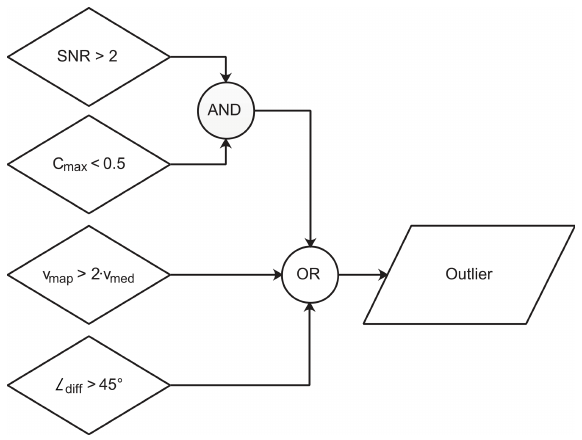
Figure 3. Two-step outlier detection approach, with C max being the maximum and C mean the absolute mean value for each correlation function. The signal-to-noise ratio (SNR) is calculated by dividing C max /C mean . V map describes the calculated flow velocity for an image pair and V med the long-time